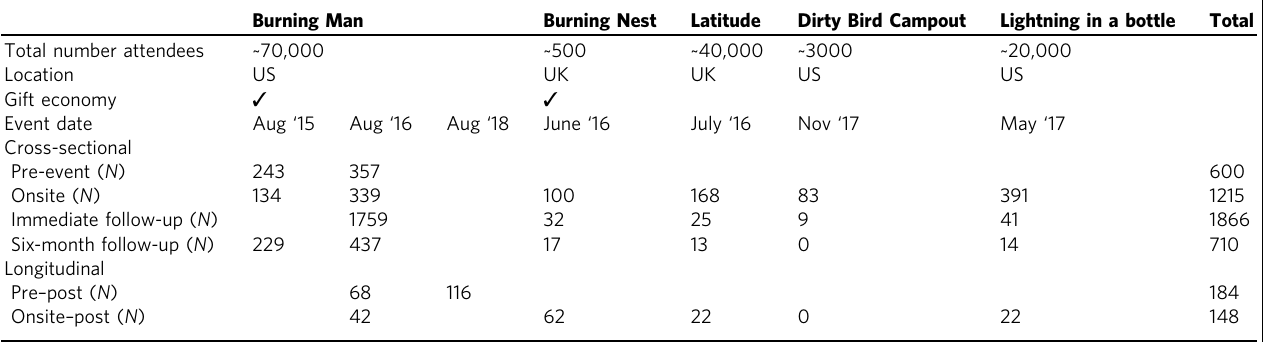
Table 1 Summary of fi eld